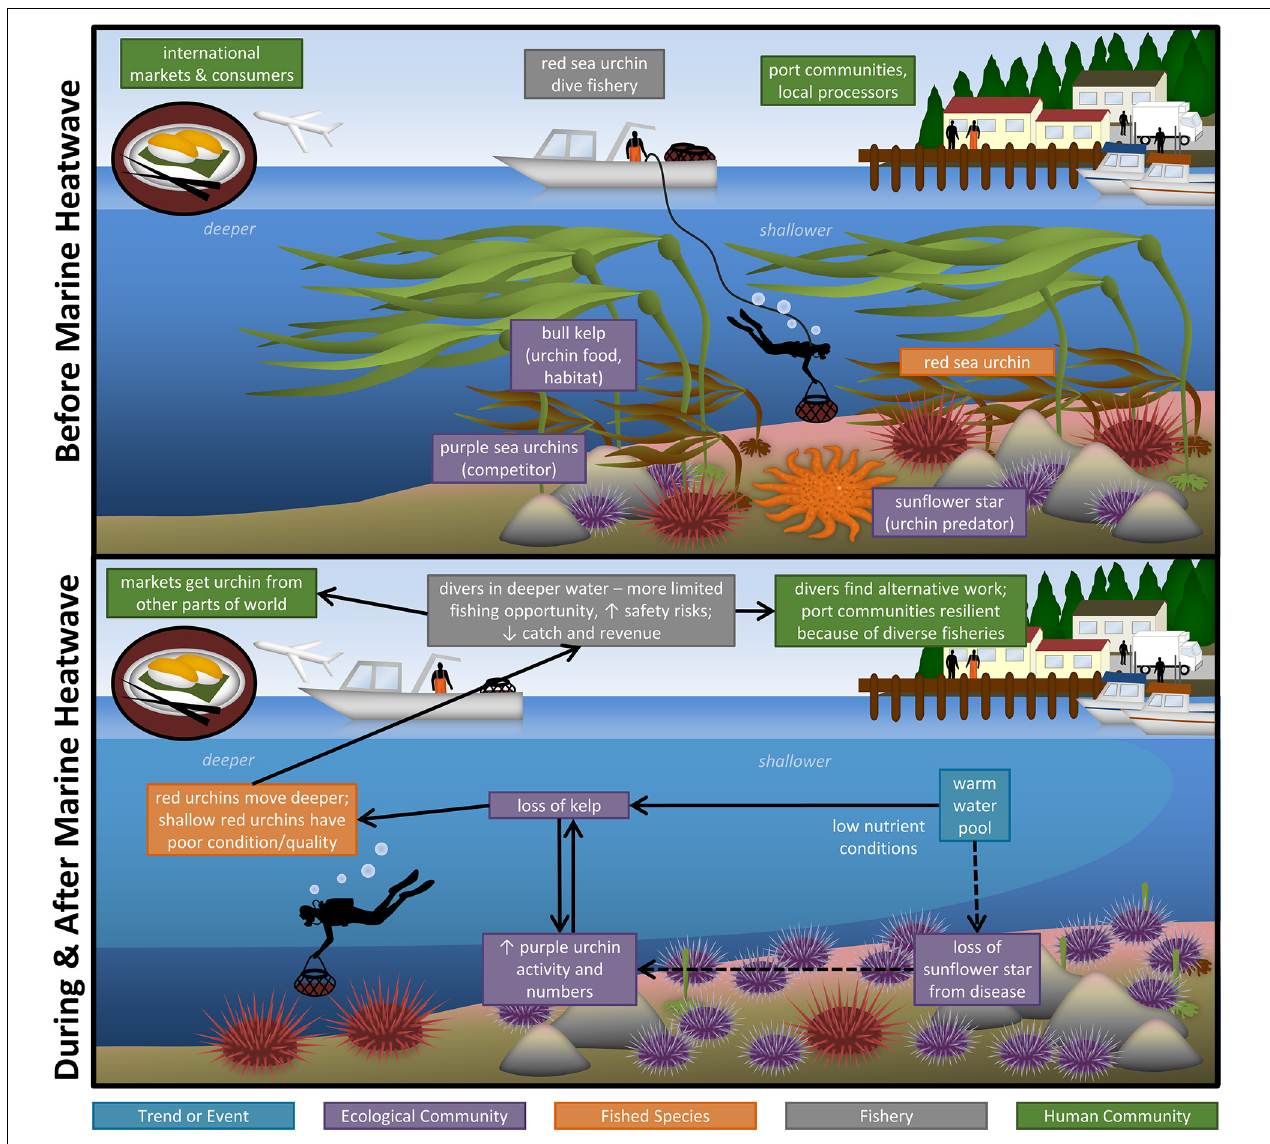
FIGURE 3 | Impacts of the North Pacific Marine Heatwave (MHW) on the northern California commercial red sea urchin fishery system. Boxes are color coded by domain and indicate the major system components (Before Marine Heatwave) and impacts of the HWM (During and After Marine Heatwave). Arrows connect exposures and impacts. Dashed (vs. solid) arrows indicate the two pathways by which the MHW impacted the fishery